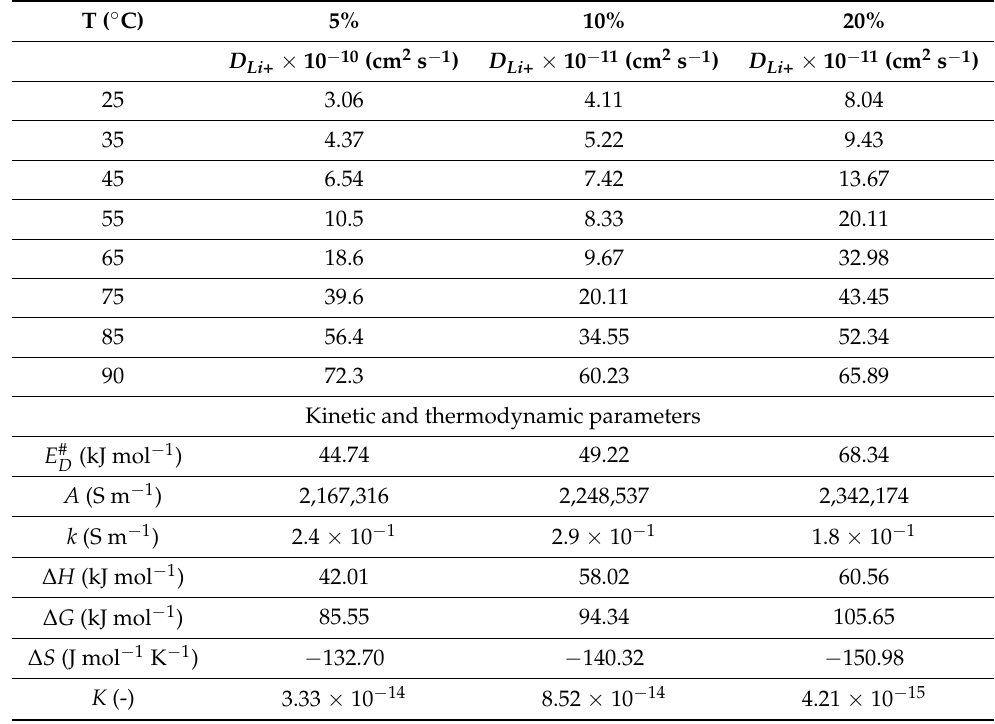
Table 4. Lithium ion diffusion coefficient, conductivity σ Li+ estimation of the anode at 25, 35, 45, 55, 65, 75, 85 and 90 ◦ C (5%, 10% and 20% wt. starch) and average kinetic and thermodynamic parameters obtained for an anode with starch-based